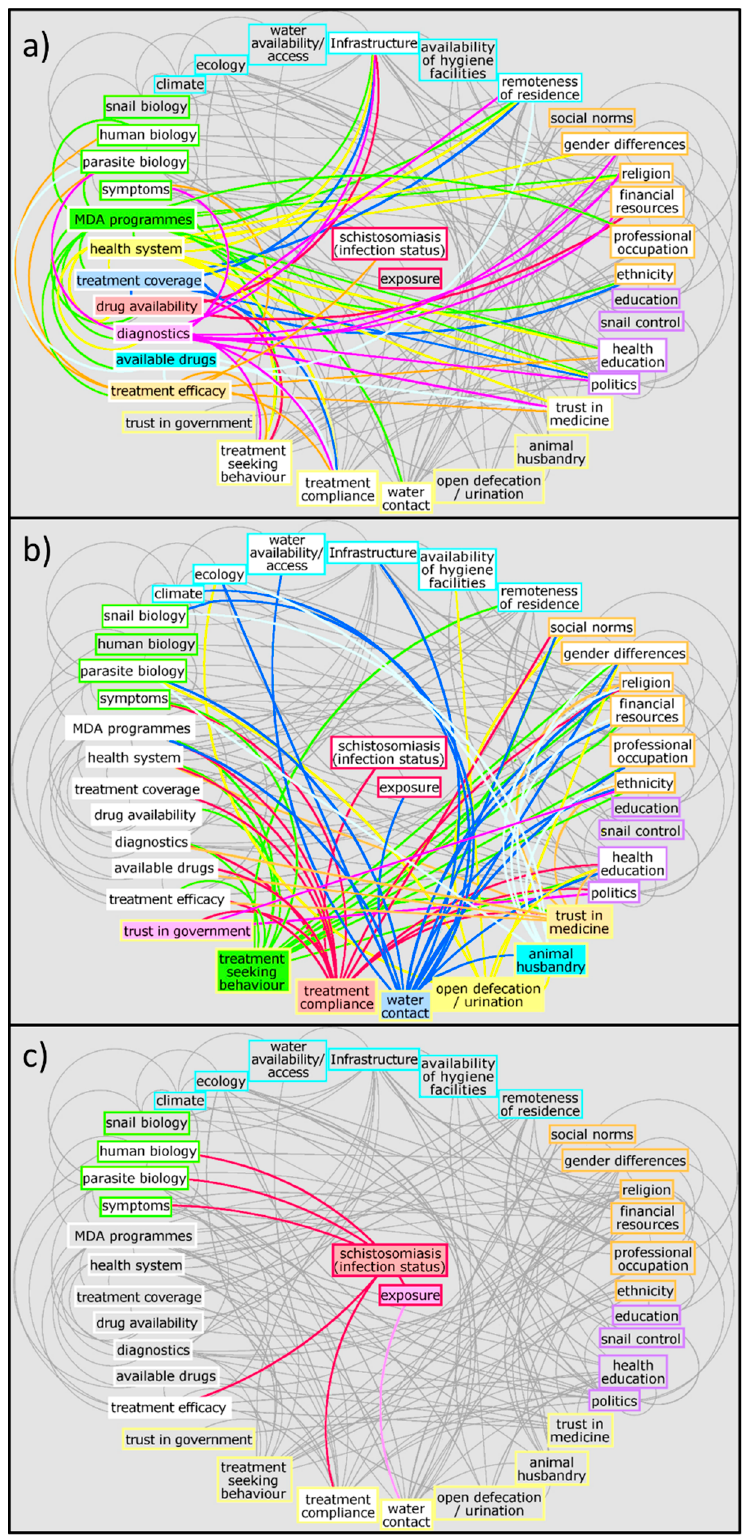
Figure 2. Potential network of factors influencing schistosomiasis infection and disease with individual connections highlighted for ( a ) clinical, ( b ) behavioural, and ( c ) exposure and infection aspects. Colours are for illustrative purposes only; white boxes indicate where the highlighted variables connect to. Different clusters are highlighted by coloured outlines: green: biological aspects; white: clinical aspects; yellow: behavioural aspects; orange: social aspects; purple: politics, policy, and services aspects; turquoise: physical environment; red: exposure and infection.